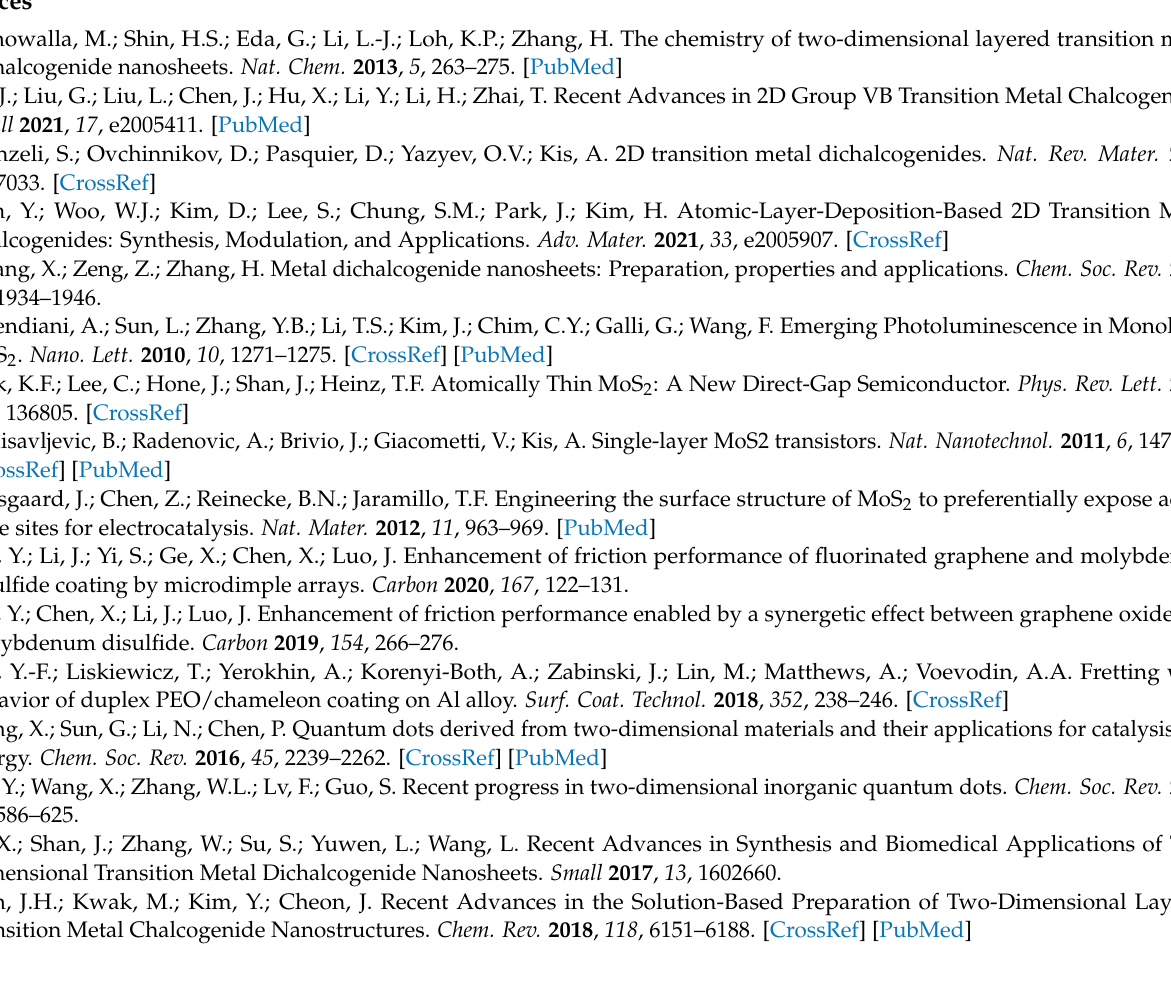
Figure S11: FT-IR spectra of bulk MoS2, MoSe2, and